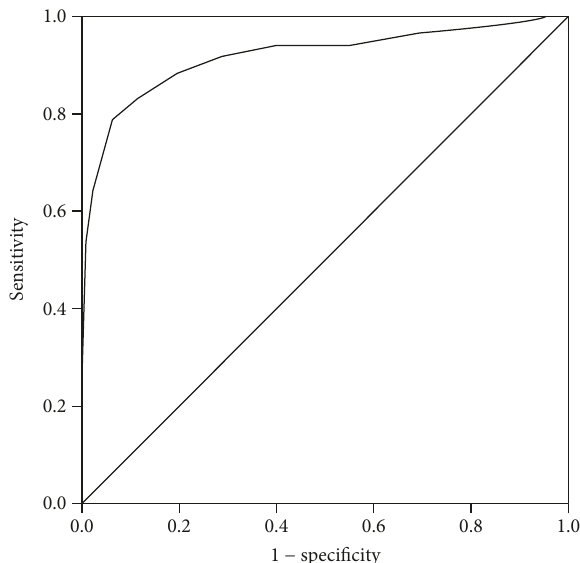
Figure 1: ROC curve analysis for the ability of HbA1c to predict diabetes de fi ned by OGTT